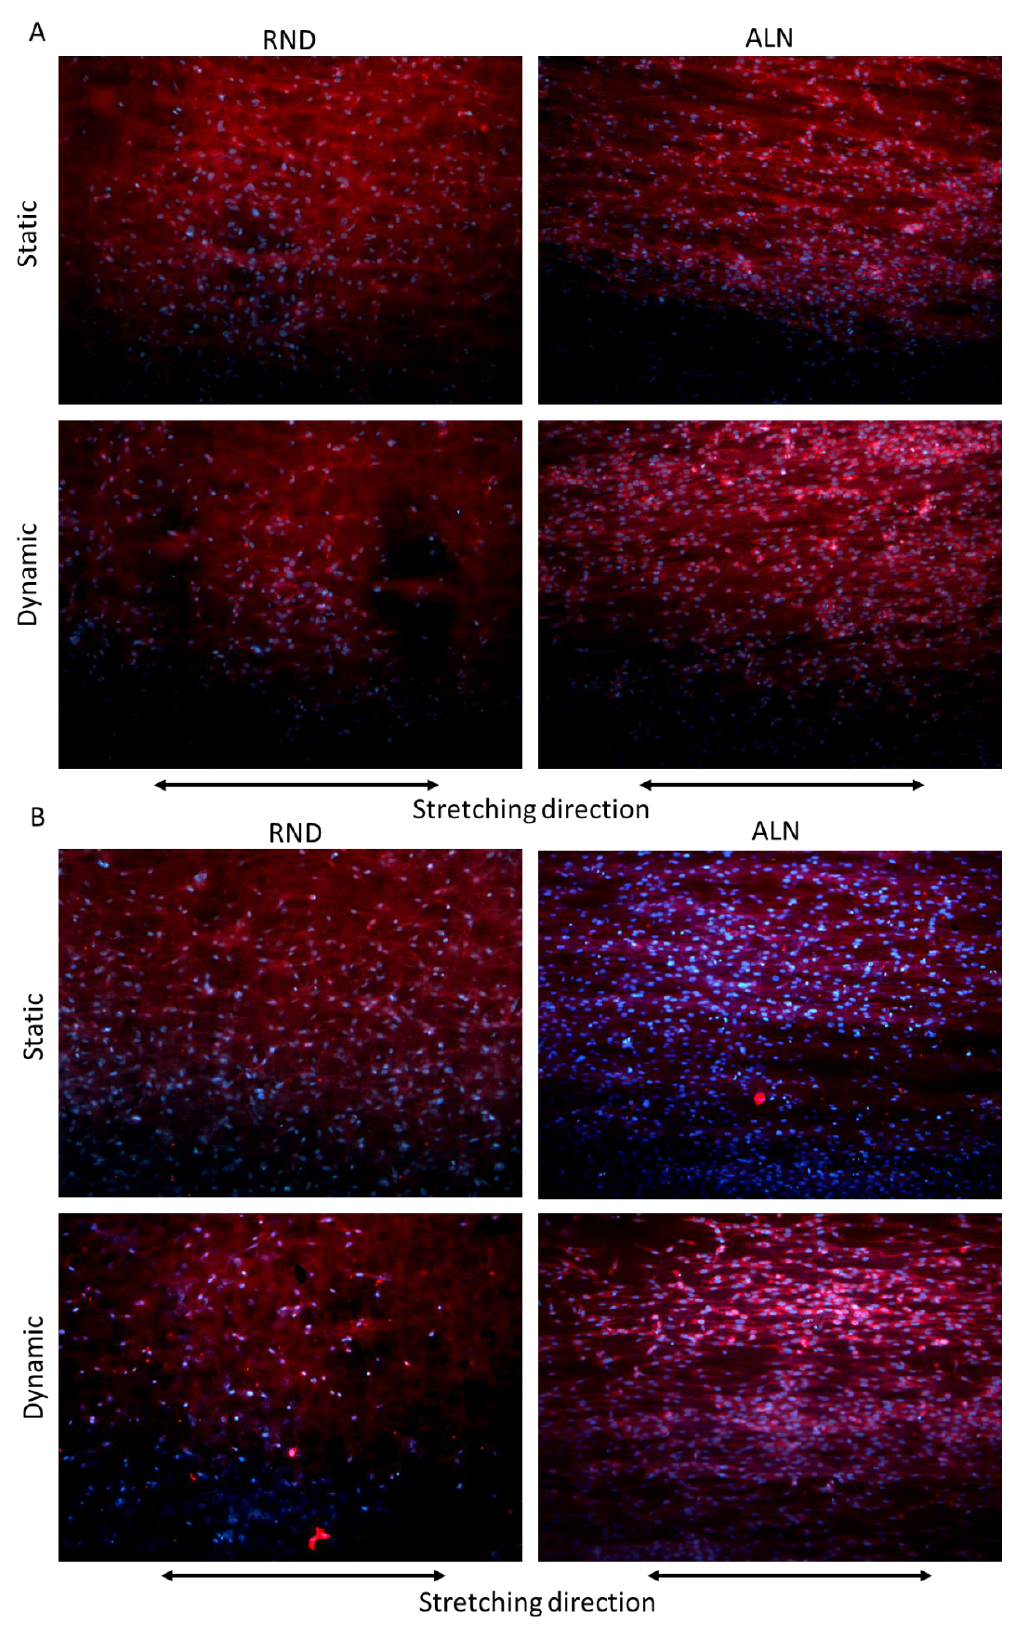
Figure 7. Phalloidin staining of endothelial cells cultured on RND and ALN scaffolds for three ( A ) and seven days ( B ). Pictures are representative of three different experiments.